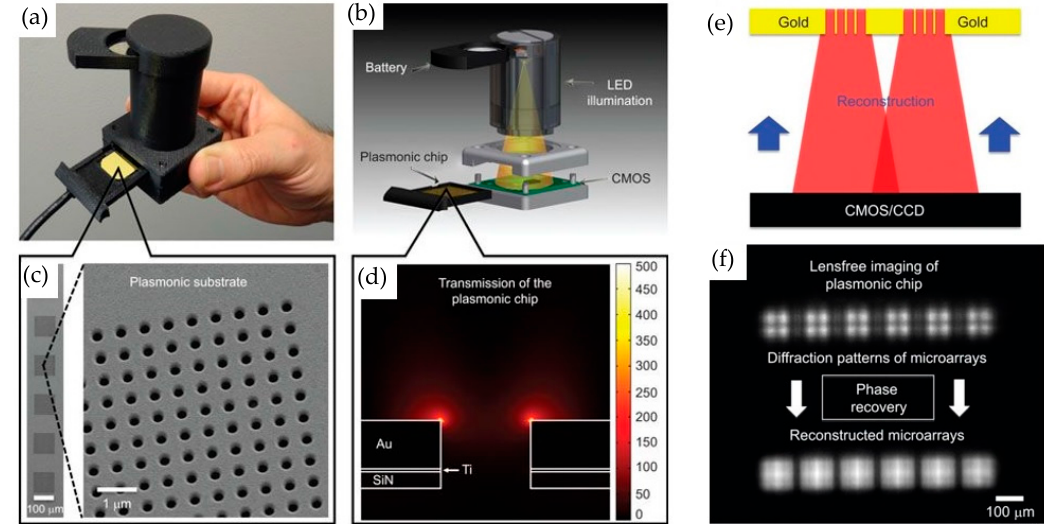
Figure 12. ( a ) Picture of the developed sensing device with sensor and imaging chip placed in compact housing as presented in Cetin et al. [77]. The total height of the device is only 7.5 cm and weighs only 60 g. ( b ) Schematic showing the components of the sensor system. ( c ) SEM image of the metallic nanohole array. ( d ) Simulation of the plasmon resonance showing intense electric field at the edges of the holes. ( e ) Illustration of the numerical technique for the reconstruction of the diffraction patterns of the nanohole array by using the phase retrieval method. ( f ) Recorded diffraction patterns of six metallic nanohole arrays (top line) and the reconstructed diffraction images by the phase retrieval method (bottom line). The distance between the nanohole array and the imager is 2 mm and no lens was used to focus the patterns. Reprinted with permission from [77]. Copyright © CIOMP (2014).